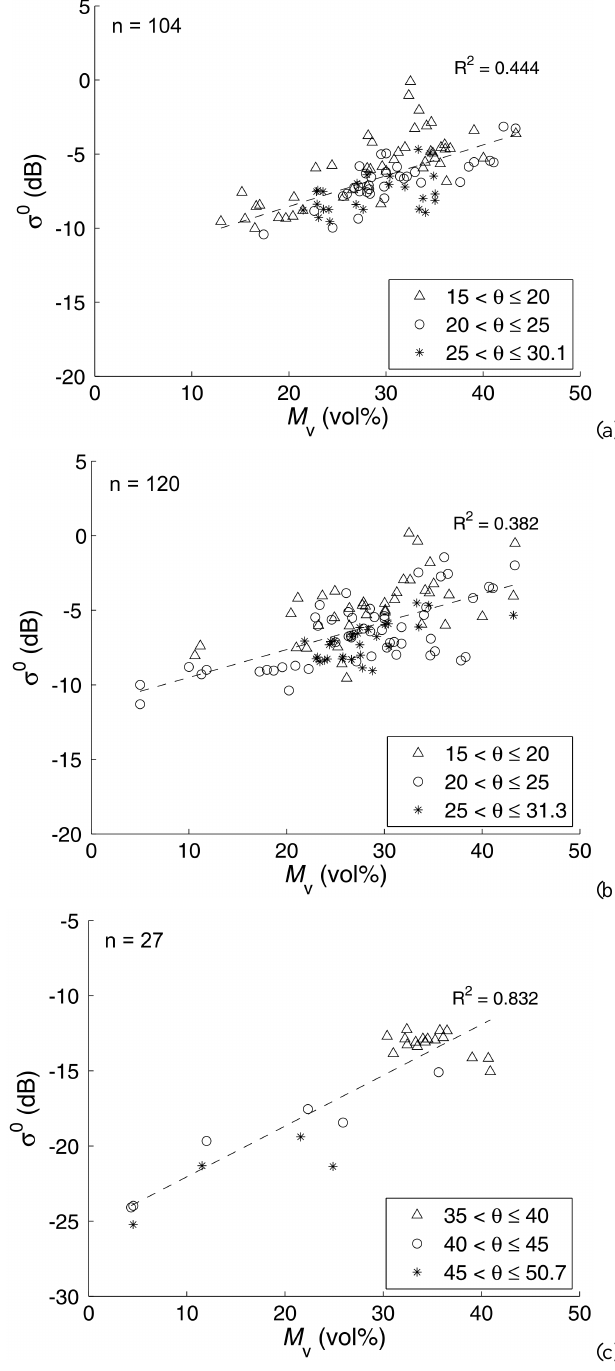
Fig. 1. Sensitivity of backscatter ( σ 0 ) to in situ soil moisture ( M v ) for different intervals of local incidence angle ( θ ) at (a) C-band HH, (b) C-band VV and (c) L-band HH configuration; n is the number of data Fig. 1. Sensitivity of backscatter ( (cid:27) 0 ) to in situ soil moisture ( M v ) for different intervals of local incidence angle ( (cid:18) ) at (a) C-band HH, (b) C-band VV and (c) L-band HH configuration; n is the number of data points. Fig. 1. Sensitivity of backscatter ( (cid:27) 0 ) to in situ soil moisture ( M v ) for different intervals of local incidence angle ( (cid:18) ) at (a) C-band HH, (b) C-band VV and (c) L-band HH configuration; n is the number of data points. Fig. 1. Sensitivity of backscatter ( (cid:27) 0 ) to in situ soil moisture ( M v ) for different intervals of local incidence angle ( (cid:18) ) at (a) C-band HH, (b) C-band VV and (c) L-band HH configuration; n is the number of data points.